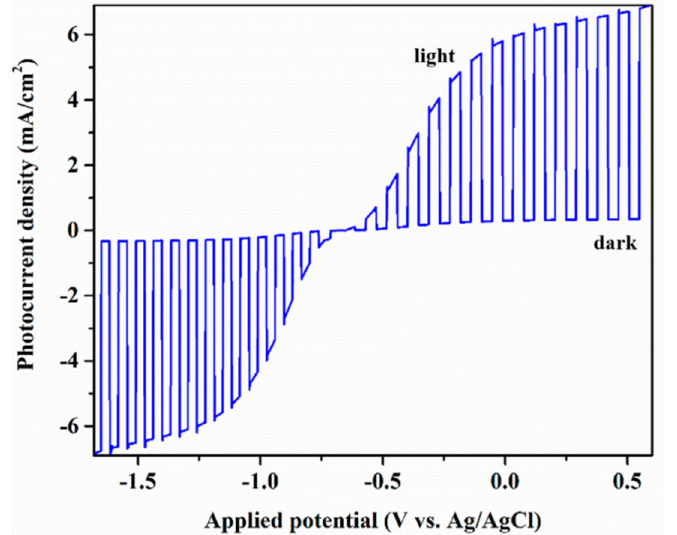
Figure 5. Voltammogram run in 0.5 M Na 2 SO 4 , chopped light for the S3 nanosheet photoanode at 50 mV s − 1